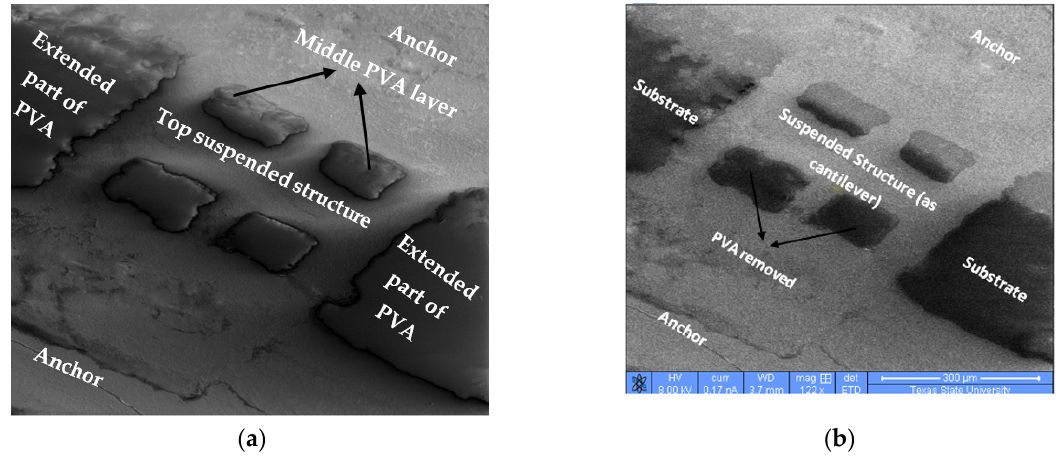
Figure 12. Mesh Cantilever structure ( a ) before PVA removal and ( b ) after PVA